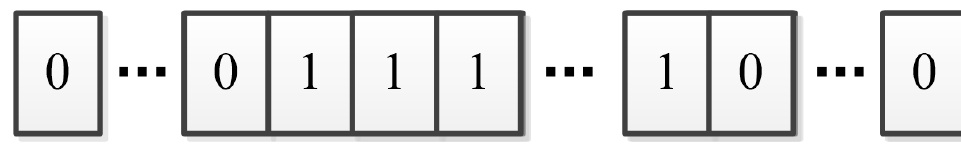
Figure 2. Filter for dark-bright-dark function. The results of region detection using the dark-bright-dark function are shown in Figure 3. As can be seen, the lane width appears wider in the proximal region and narrower in the distant region of the input image. The actual lane area is calculated correctly, even when the lane width appears different along the input image, using various scales for the actual size of the black ( 0 ) and white ( 1 ) areas of the filter for the dark-bright-dark function.